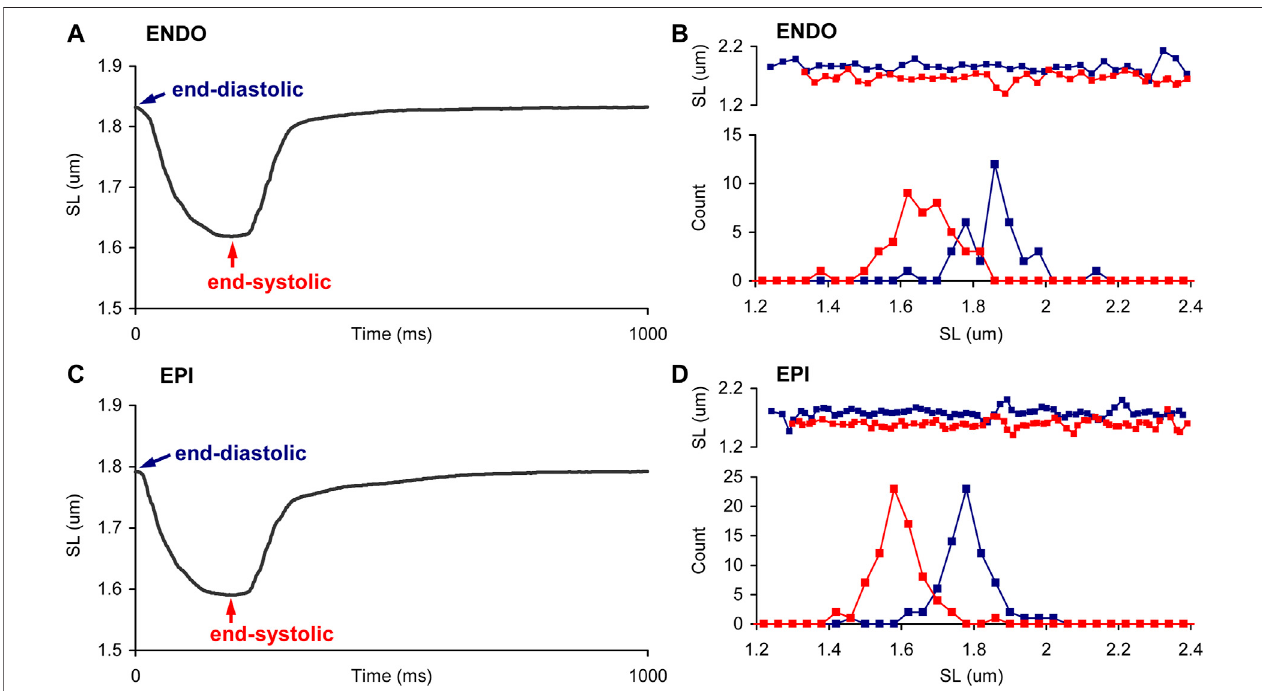
FIGURE2| SarcomerelengthdistributioninENDOandEPImyocytesduringthecontraction. (A,C) RepresentativeSLchangesintime,averagedfromoneROIina single paced ENDO (A) and EPI (C) cardiomyocyte at 1 Hz. (B,D) . Representative distributions, obtained in end-diastole (EDSL, blue) and end-systole (ESSL, red), in ENDO (B) and EPI (D) cardiomyocytes. Top panels show plots of individual SL values as function of their position along the ROI. The SL values of each cardiomyocyte werederivedfromframesrecordedduringend-diastoleorend-systole;severalconsecutivetwitchesweresuperimposed.ThedistributionsofindividualSLsetsare plotted with a bin size of 0.04